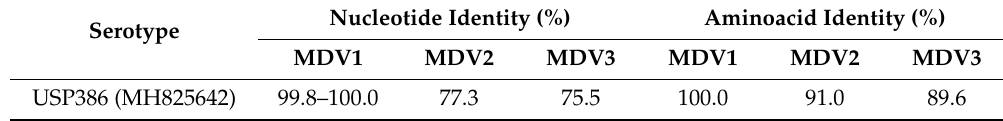
Table 4. The nucleotide and deduced amino acid identities of the USP386 and MDV serotypes.